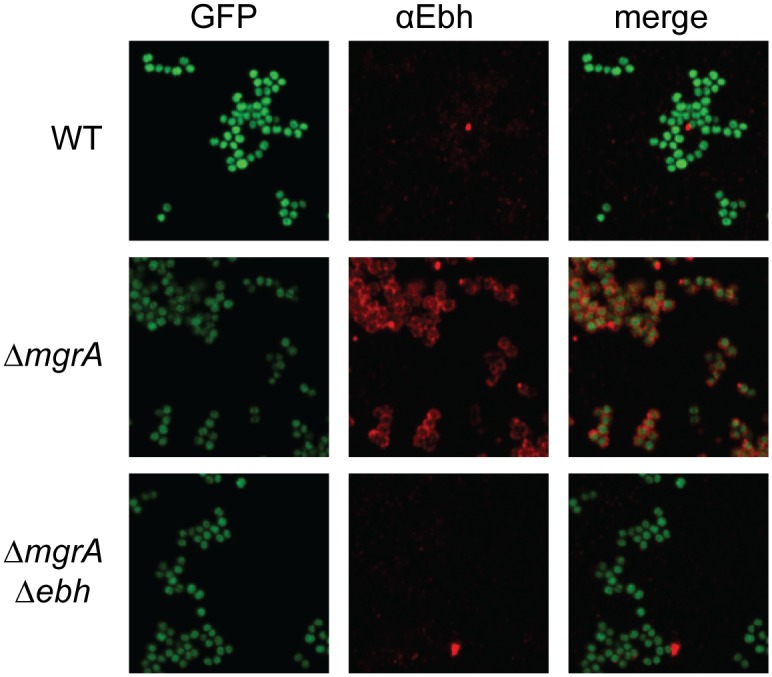
Immunofluorescence microscopy showing overproduction of Ebh in the mgrA mutant.All strains constitutively expressed GFP and were probed for Ebh using Alexa fluor 568-labeled secondary antibodies, as described in the methods.